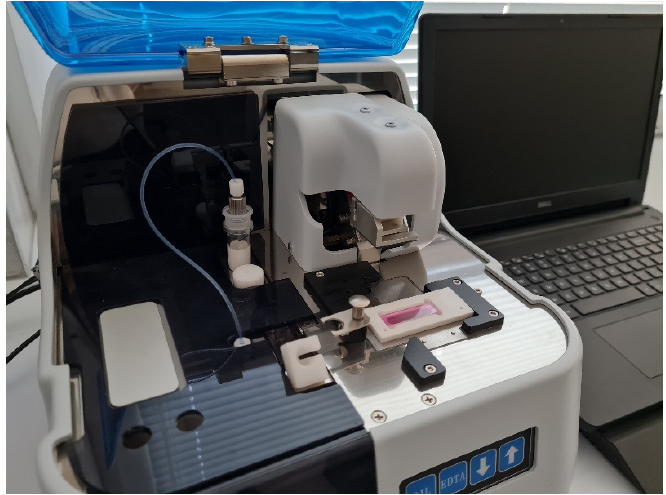
Figure 1. Total thrombus formation analysis system.